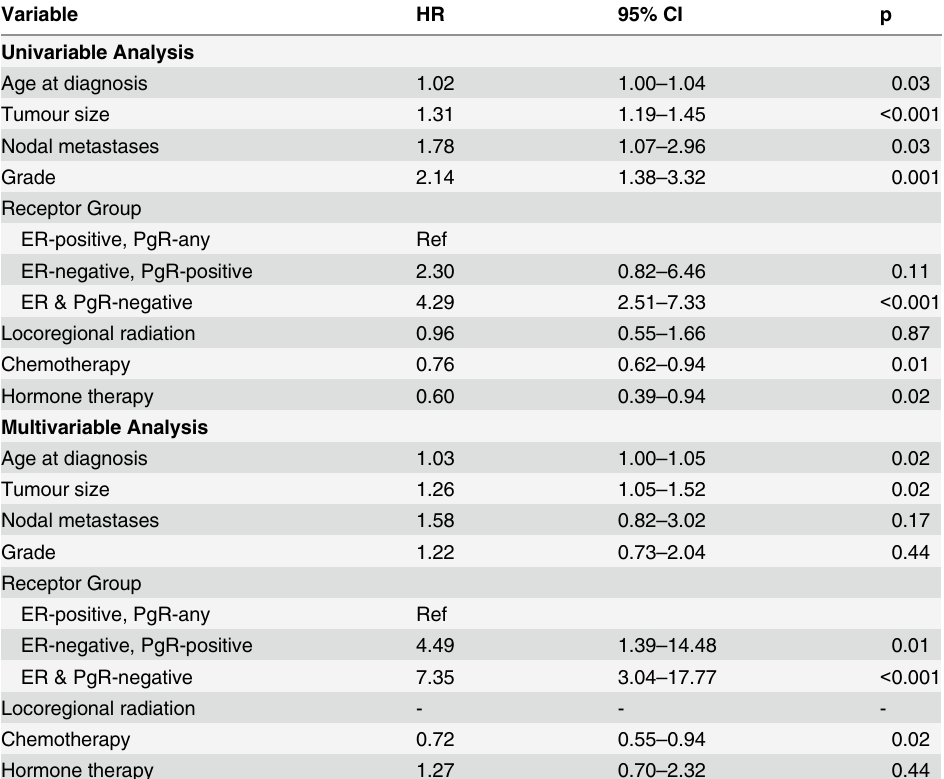
Table 5. Univariable and multivariable analyses for overall survival in sensitivity analysis excluding patients with HER2-positive